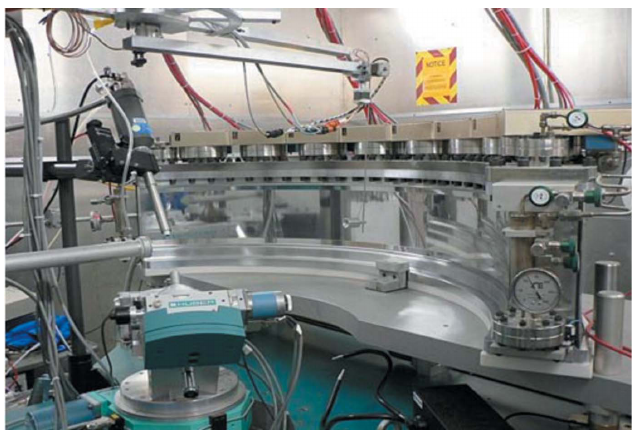
Figure 4 Overview of the PCS detector environment. On the left is the beam pipe, Oxford Cryosystems cryocooling arm and kappa goniometer. On the right is the 3 He detector